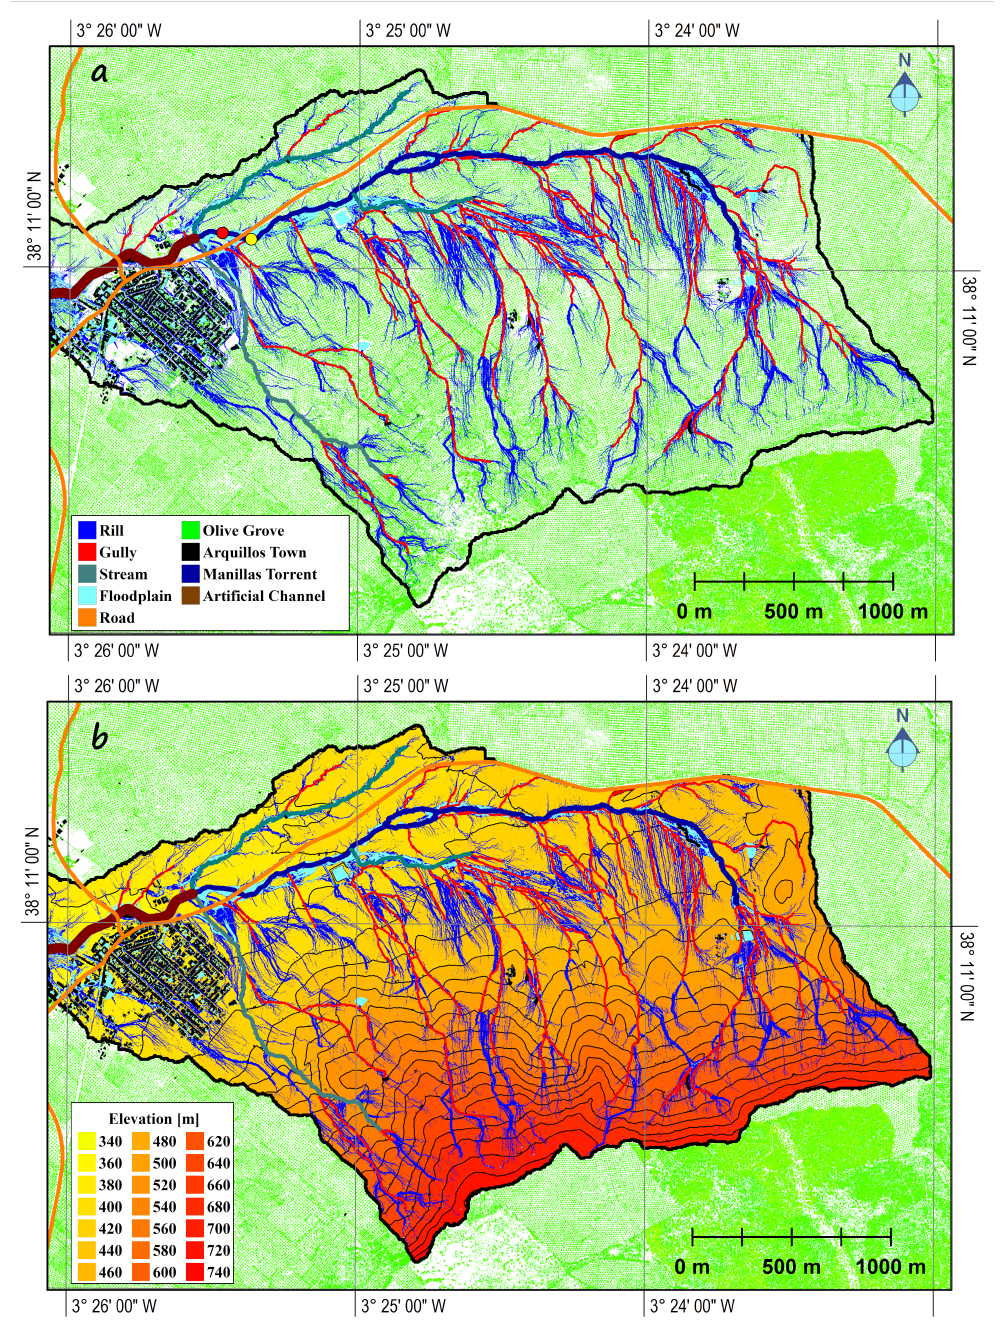
Figure 1. General characteristics of the Manillas basin in Arquillos (Jaén, Southeast Spain). ( a ) Catch- ment overview (perimeter highlighted with the black solid line) with three regions of interest: the urban areas (black), the man-made channel that should protect the town from inundation (thick line in brown), and olive trees (green dots). The drainage network is composed of rills, gullies, and streams. ( b ) Hypsometric map and drainage network. For completeness, main traffic roads are coloured in orange. Maps created from scratch with Matlab and GlobalMapper based on a Light Detection and Ranging (LiDAR) dataset acquired on May 2021 with 1.5 points per square meter (https://www.ign.es/, accessed on 1 July 2022). Rills, gullies, and streams were obtained from the distributed hydrological simulations presented in this